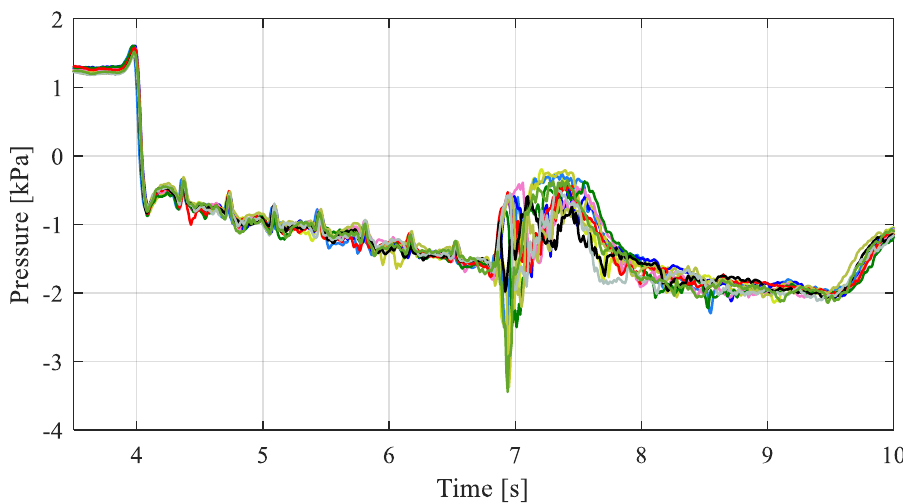
Figure 8. Example of the pressure fluctuations measured in the wake region for 10 different runs.